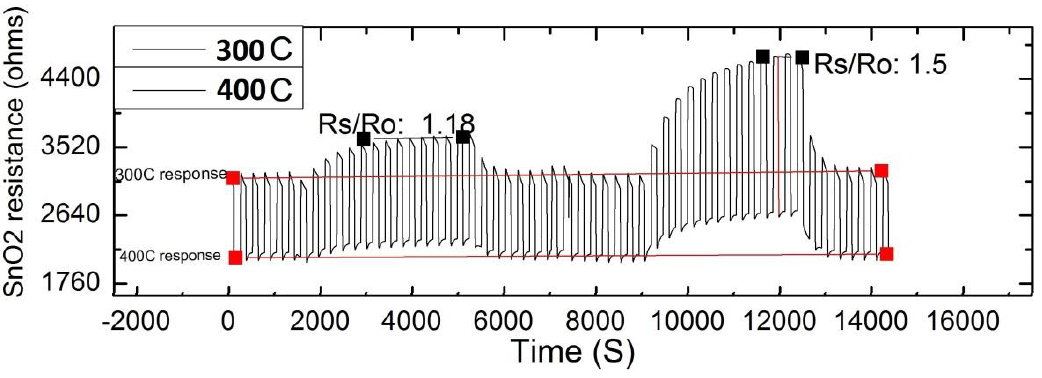
Figure 3. Response of the SnO 2 sensor for different concentrations of CH 4 . The cycling temperature of the heater was 300 ° C for 2.5 min and 400 °C for 2